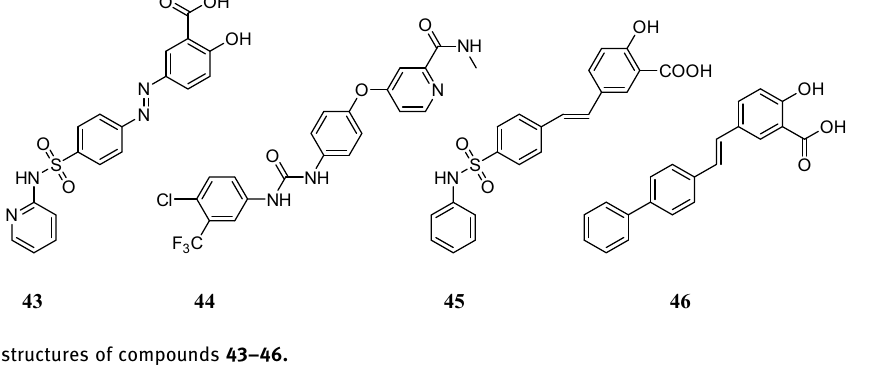
Figure 15: Chemical structures of compounds 43 – 46.